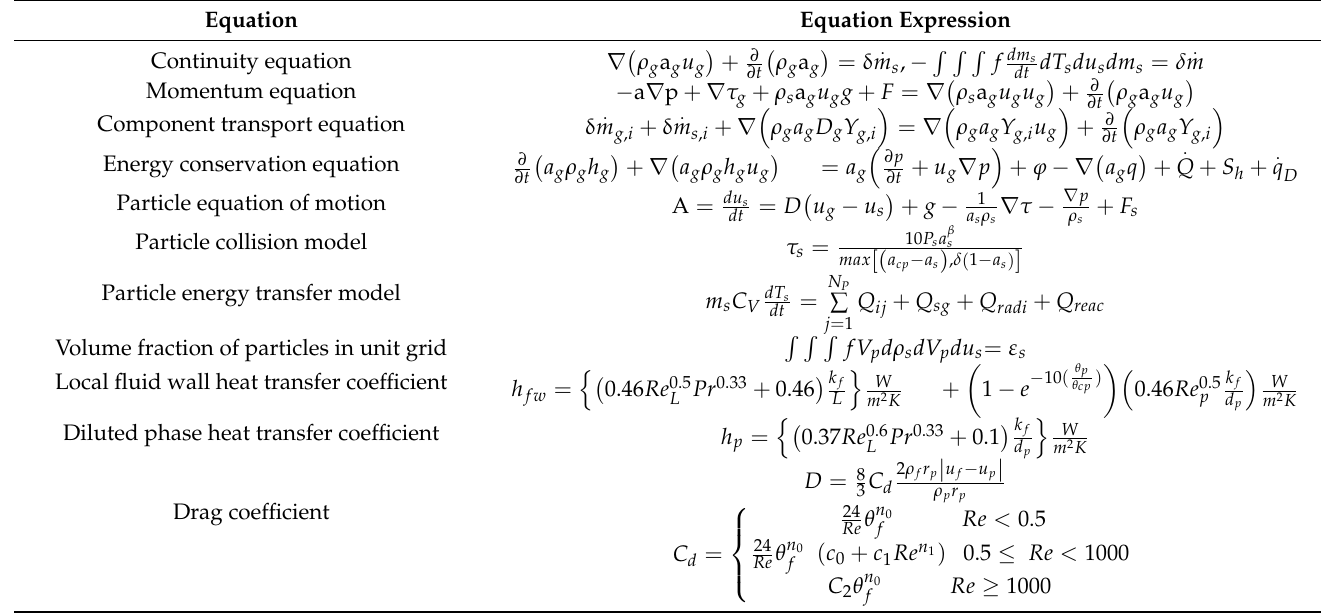
Table 2. Governing equations